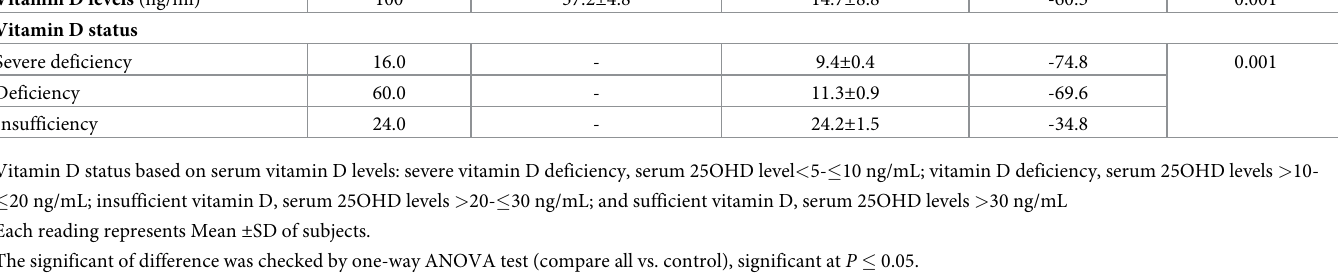
Table 3. Vitamin D status of participants in case and control groups. Parameter